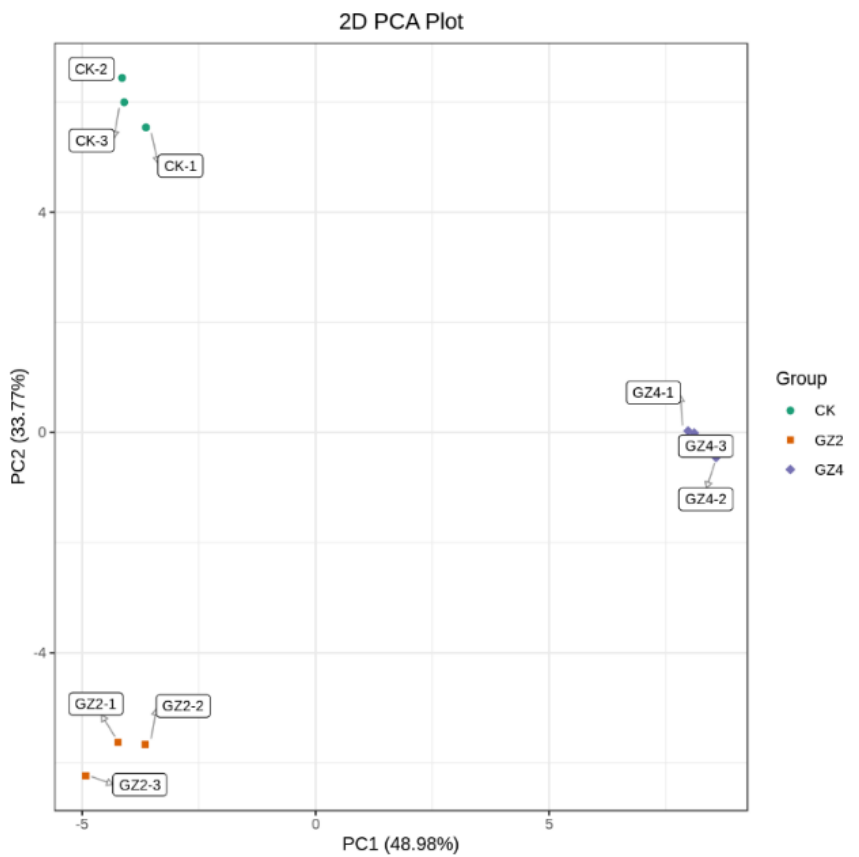
Figure 3. PCA analysis of the flavonoid metabolites in the leaves of C. drupifera under aluminum stress.